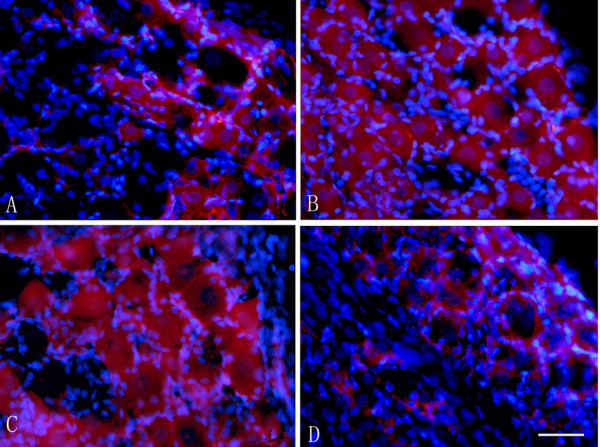
Increased BDNF expression in the DRG after hind-paw incision. Representative photomicrographs showing immunostaining of BDNF (red) in the ipsilateral DRG after hind-paw incision (Figure 3B-D) or the control (Figure 3A). The nuclei were stained by Hoechest (blue). Increased BDNF expressing neurons were observed at 1 hour after incision (Figure 3B) and sustained 1 day after incision (Figure 3C). The expression of BDNF at 3 days after incision (Figure 3D) went back to the basal level. Bar = 40 μm.